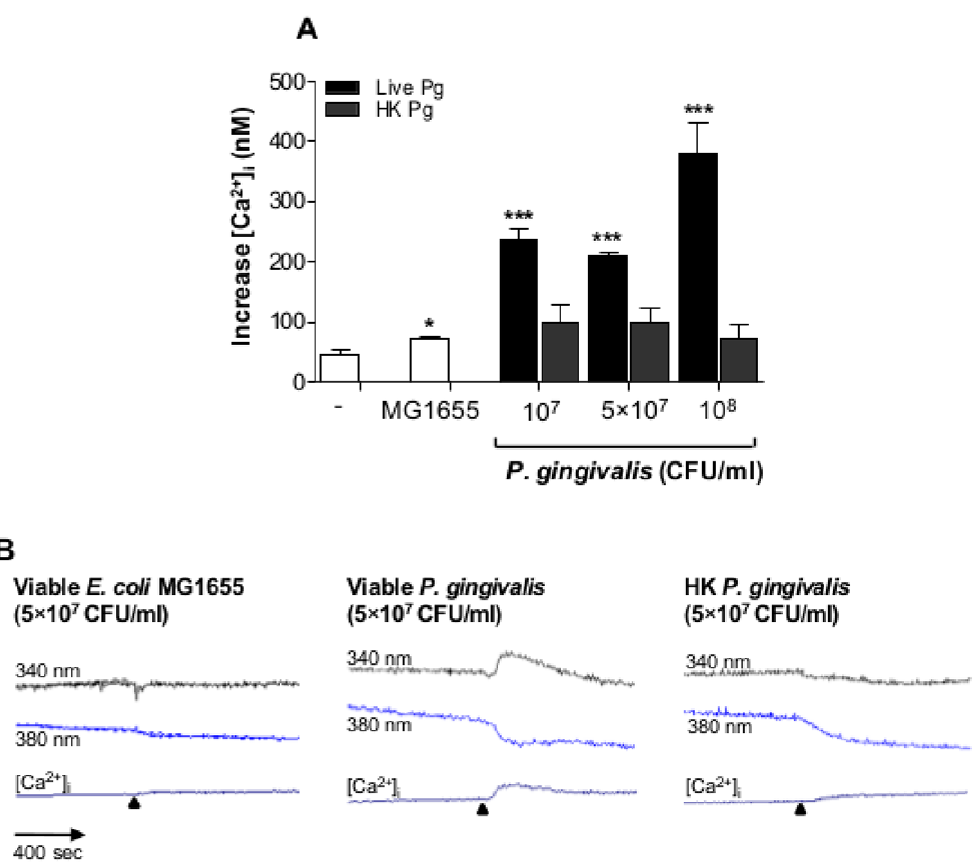
Figure 1. Viable P.gingivalis increased [Ca 2 + ] i concentration in Jurkat T-cells. [Ca 2 + ] i was measured by loading Jurkat T-cells (10 6 cells/ml) with the fluorescent indicator Fura-2. A - Cells were exposed to the indicated concentrations of either viable (black bars)- or heat-killed (HK, grey bars) P. gingivalis or Viable E. coli MG1655 (5 6 10 7 CFU/ml, MOI:50). Ca 2 + release was induced in response to viable, but not heat-killed bacteria (MOI:10, 50 and 100, respectively). B - Representative curves of the excitation wavelengths 340 nm and 380 nm as well as the calculated Ca 2 + concentrations following treatment of Jurkat T-cells with viable E. coli MG1655, viable P. gingivalis and heat-killed P. gingivalis , respectively. The arrows indicate the starting point of stimulation. Data shown are the mean 6 SD of three independent experiments. *-p , 0.05; ***-p , 0.001 (Student’s t